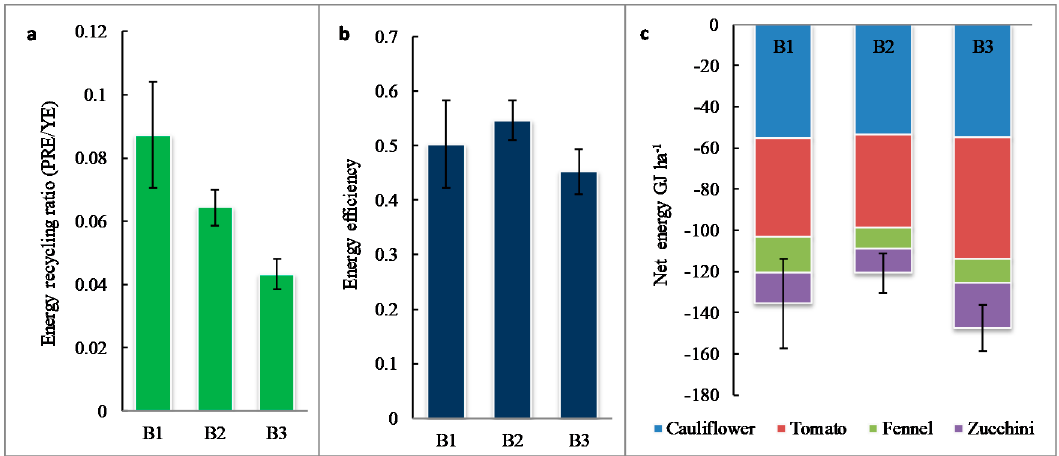
Figure 4. Energy parameters: ( a ) PRE/YE; ( b ) energy efficiency ((PRE + YE)/INPUT); ( c ) net energy (GJ ha − 1 ) (PRE + YE – INPUT) divided by crops (B1 = alfalfa as living mulch during both winter and summer periods, flattened with a no-till roller crimper; B2 = clover as living mulch during the winter period, chopped and plowed as green manure; B3 = control without ASC).